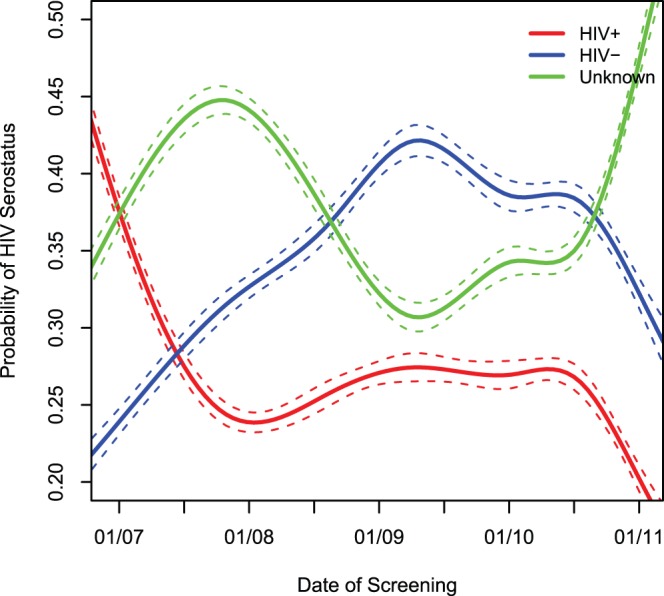
Probability of individual HIV serostatus among women utilizing services of the Cervical Cancer Prevention Program in Zambia (CCPPZ).